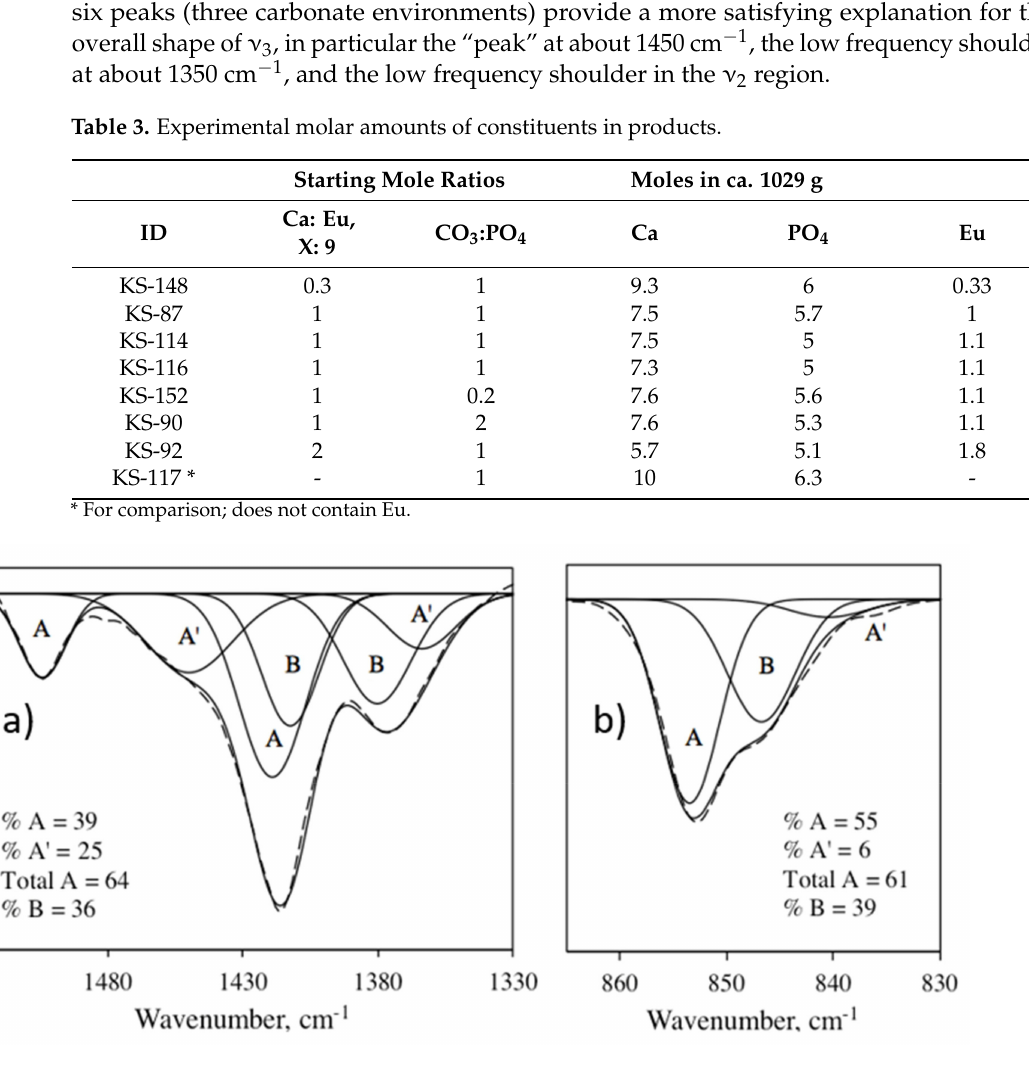
Figure 2. The carbonate asymmetric stretch ( ν 3 ) ( a ) and out-of-plane bend ( ν 2 ) ( b ) regions of the IR spectrum of